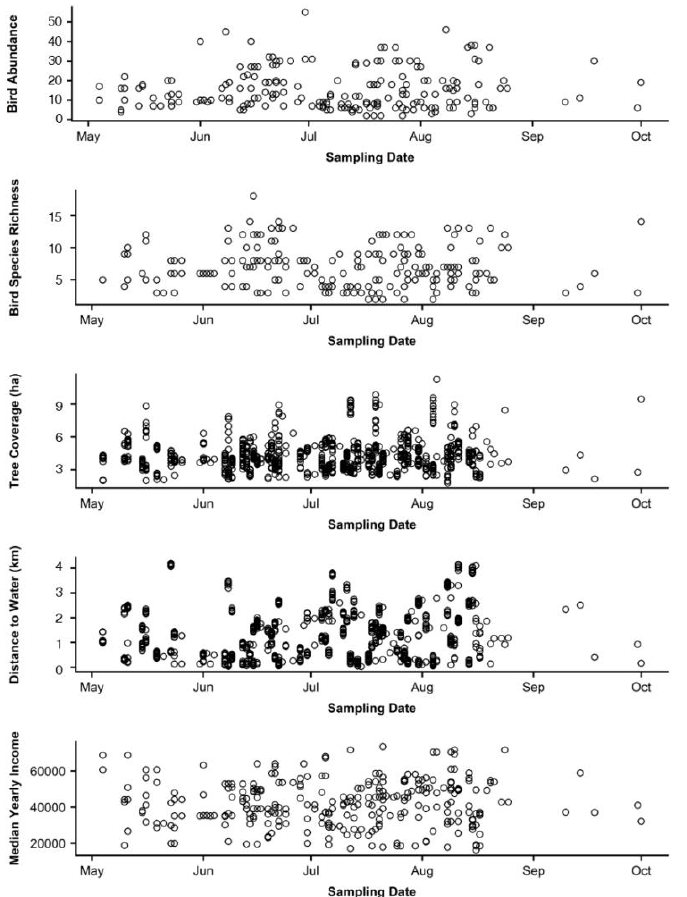
Figure A1. Relationships between survey date and each of the predictor variables. The sequence of surveys was designed to avoid any confounding of survey date with any of the predictor variables (see Methods).